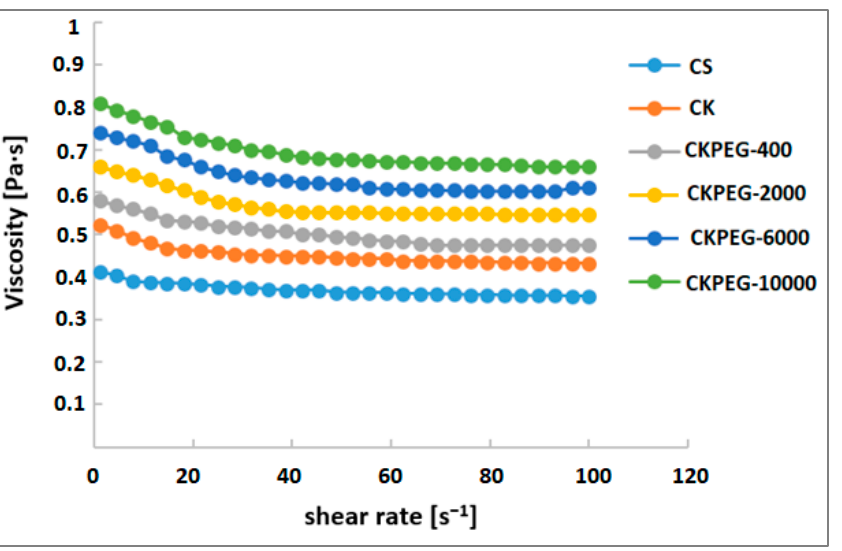
Figure 2. In fl uence of the shear rate on the rheological curves of di ff erent composite suspensions (T = 25 °C).